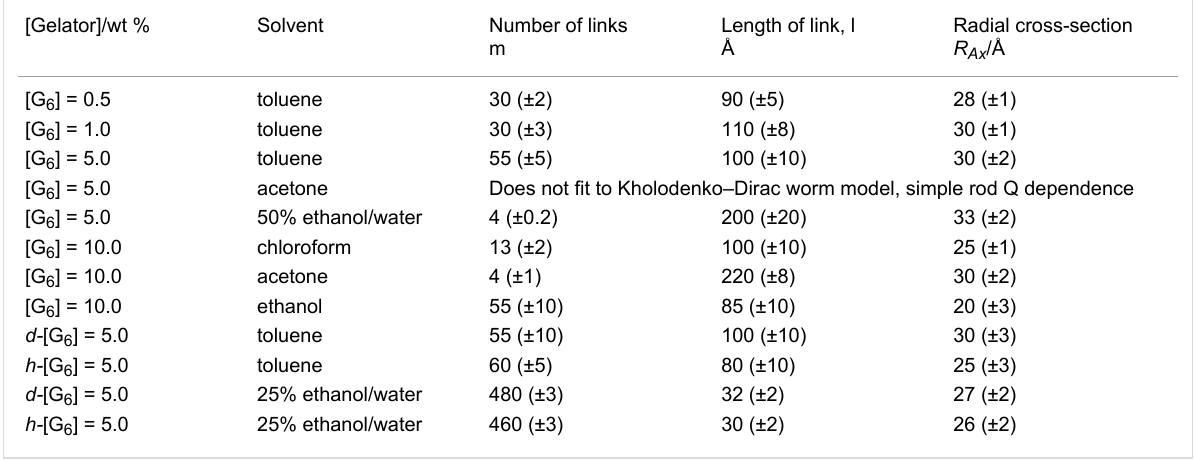
Table 1: Parameters describing the fit to the SANS data using the Kholodenko–Dirac worm model. [Gelator]/wt % Solvent Number of links